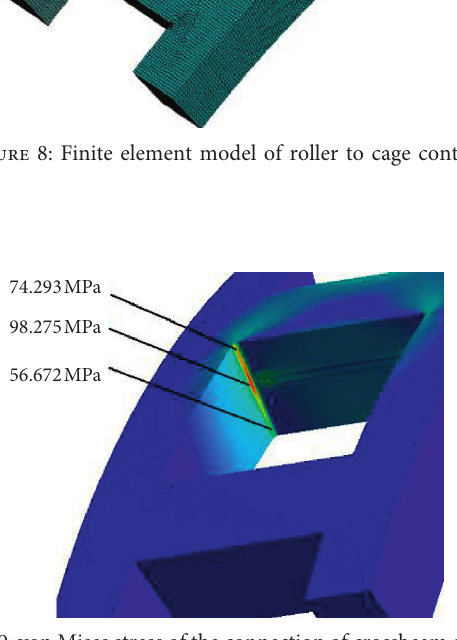
Figure 9: von Mises stress of the connection of crossbeam and side beam at the stage of